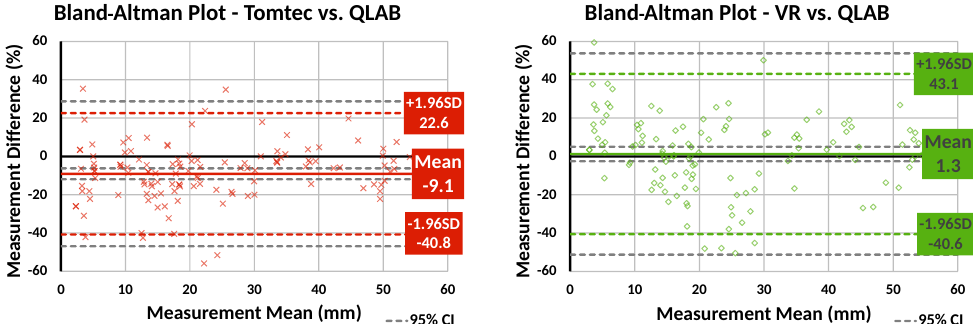
Figure 6. Bland–Altman plots comparing line measurements made using our VR system and Tomtec CardioView to Philips QLAB. Our VR system’s measurements show less bias than Tomtec, but greater